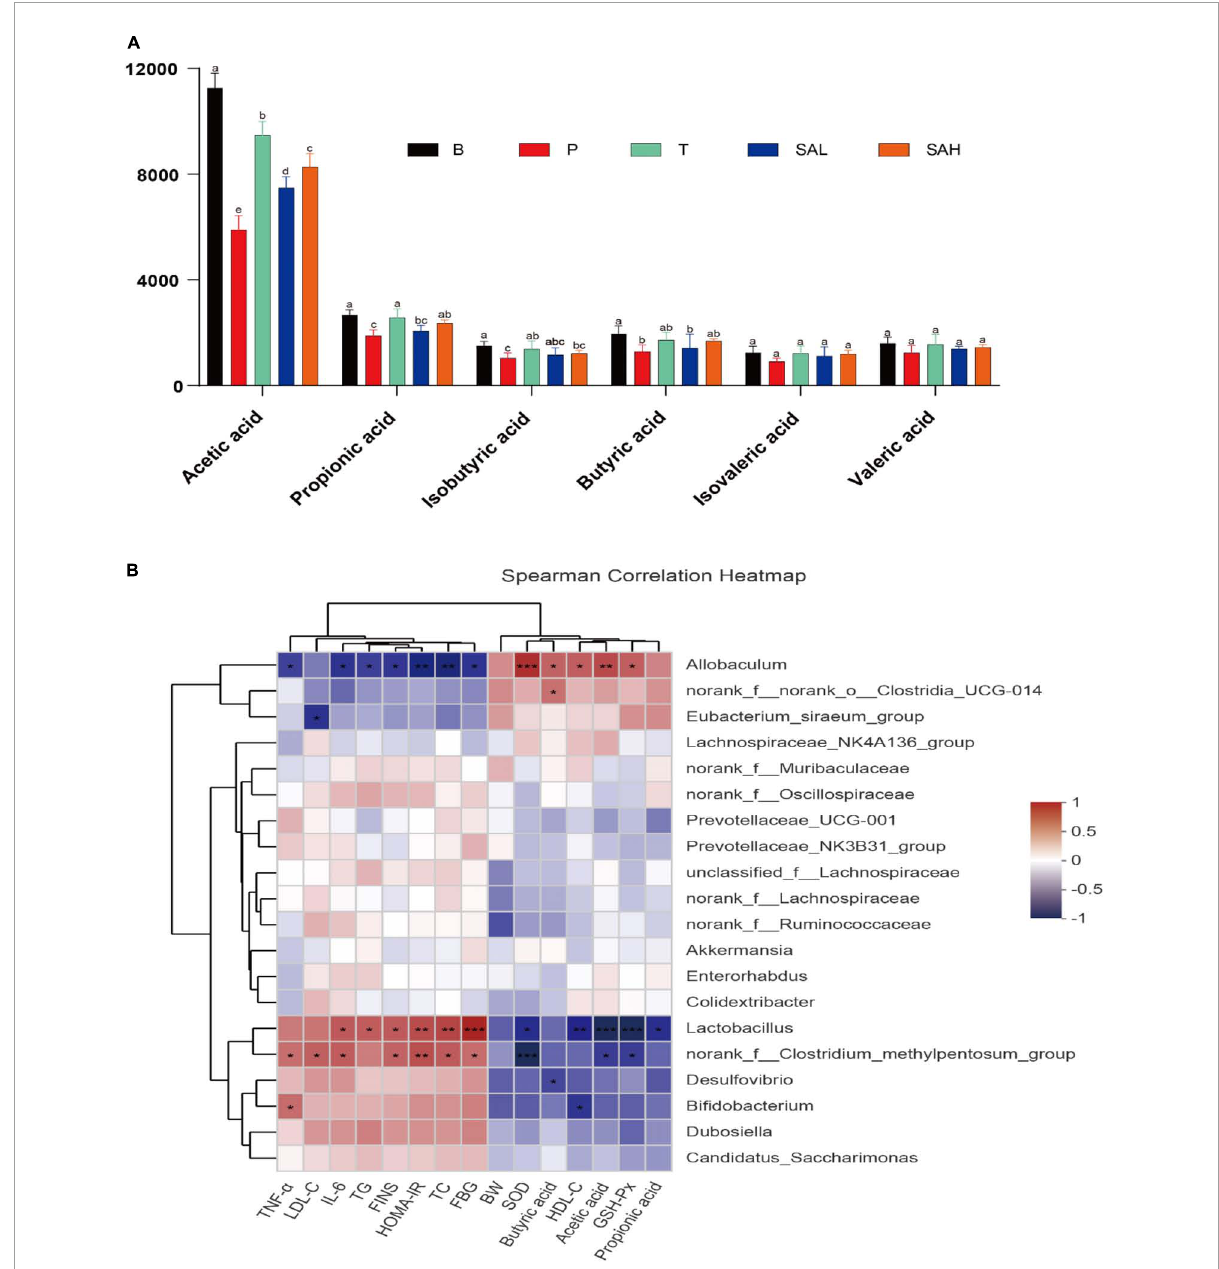
FIGURE9 Correlation analysis between biochemical parameters and intestinal microbiota at the genus level. (A) SCFAs, (B) Spearman’s correlation analyses were used to analyze the relative abundance between the specific genus in each group. Data were presented as the mean ± SD ( n = 6). Groups with different letters are significantly different ( P < 0.05). B, control group; P, diabetic model group; T, (HFD + 200 mg kg – 1 Met); SAL, (HFD + 70 mg kg – 1 TGP); SAH, (HFD + 280 mg kg – 1